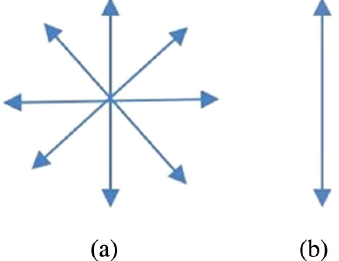
fences.FIG. 1. Schematic textbook representation of unpolarized light (a) and polarized light (b). The arrows are said to show the direction of the oscillations of light.